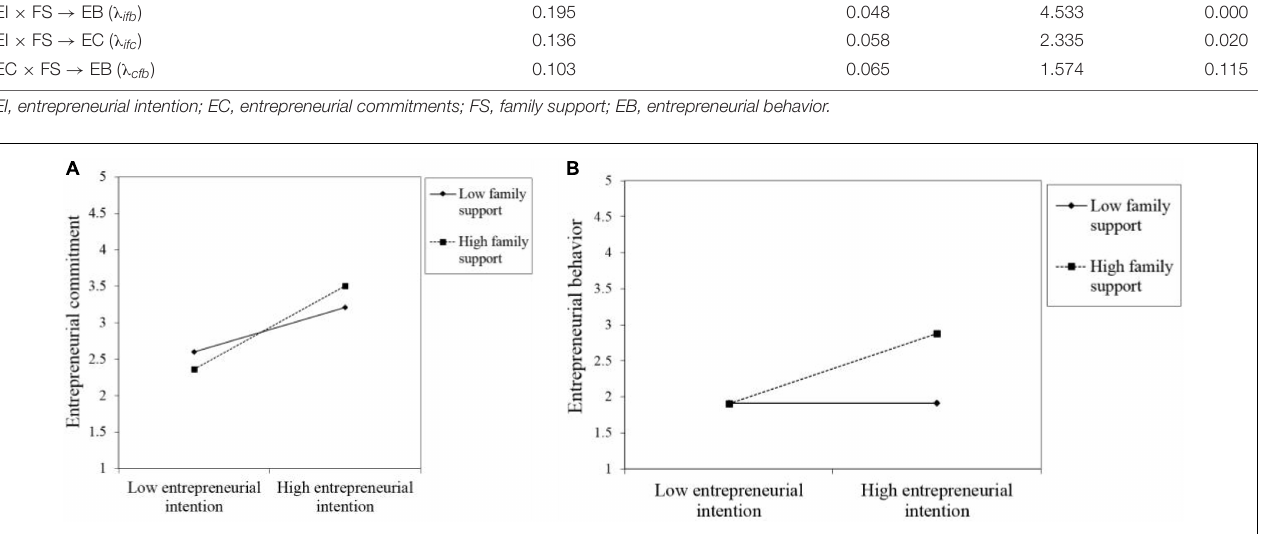
TABLE 5 | The result of the moderating effect. Relationship of the hypothetical path